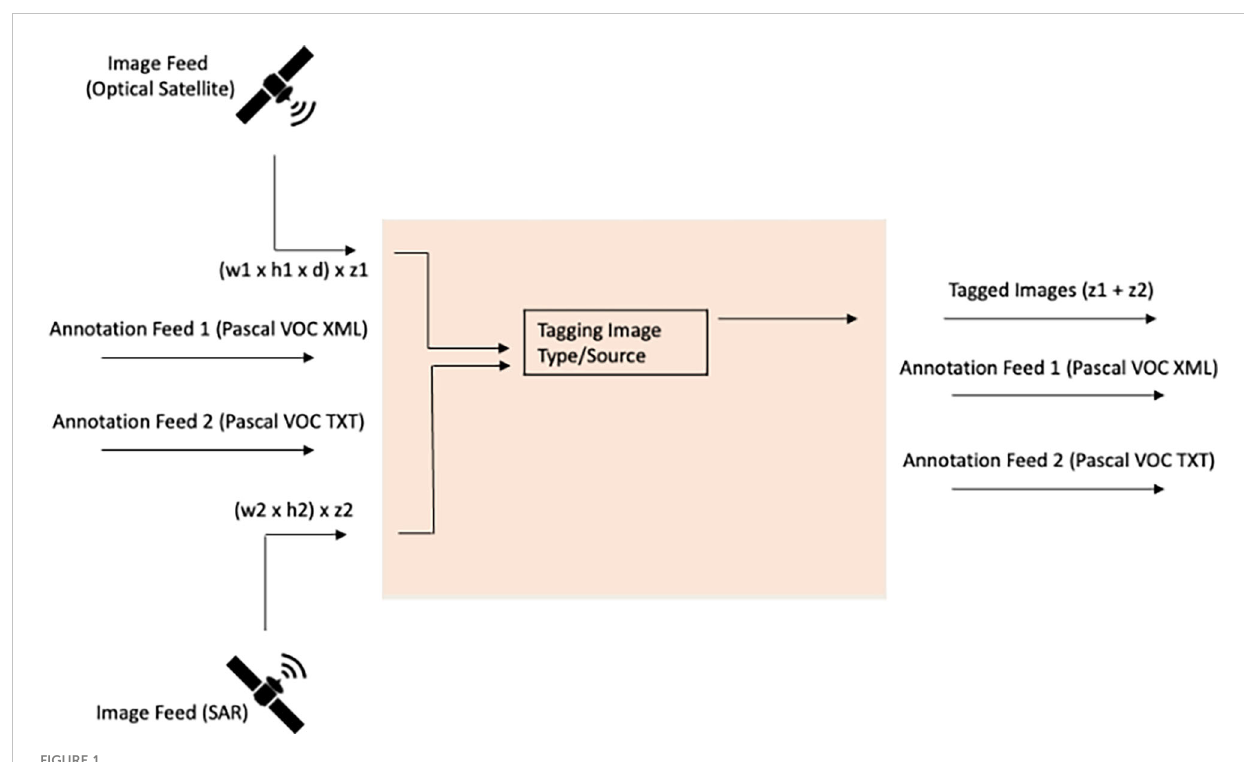
FIGURE 1 Image Capture Subsystem.